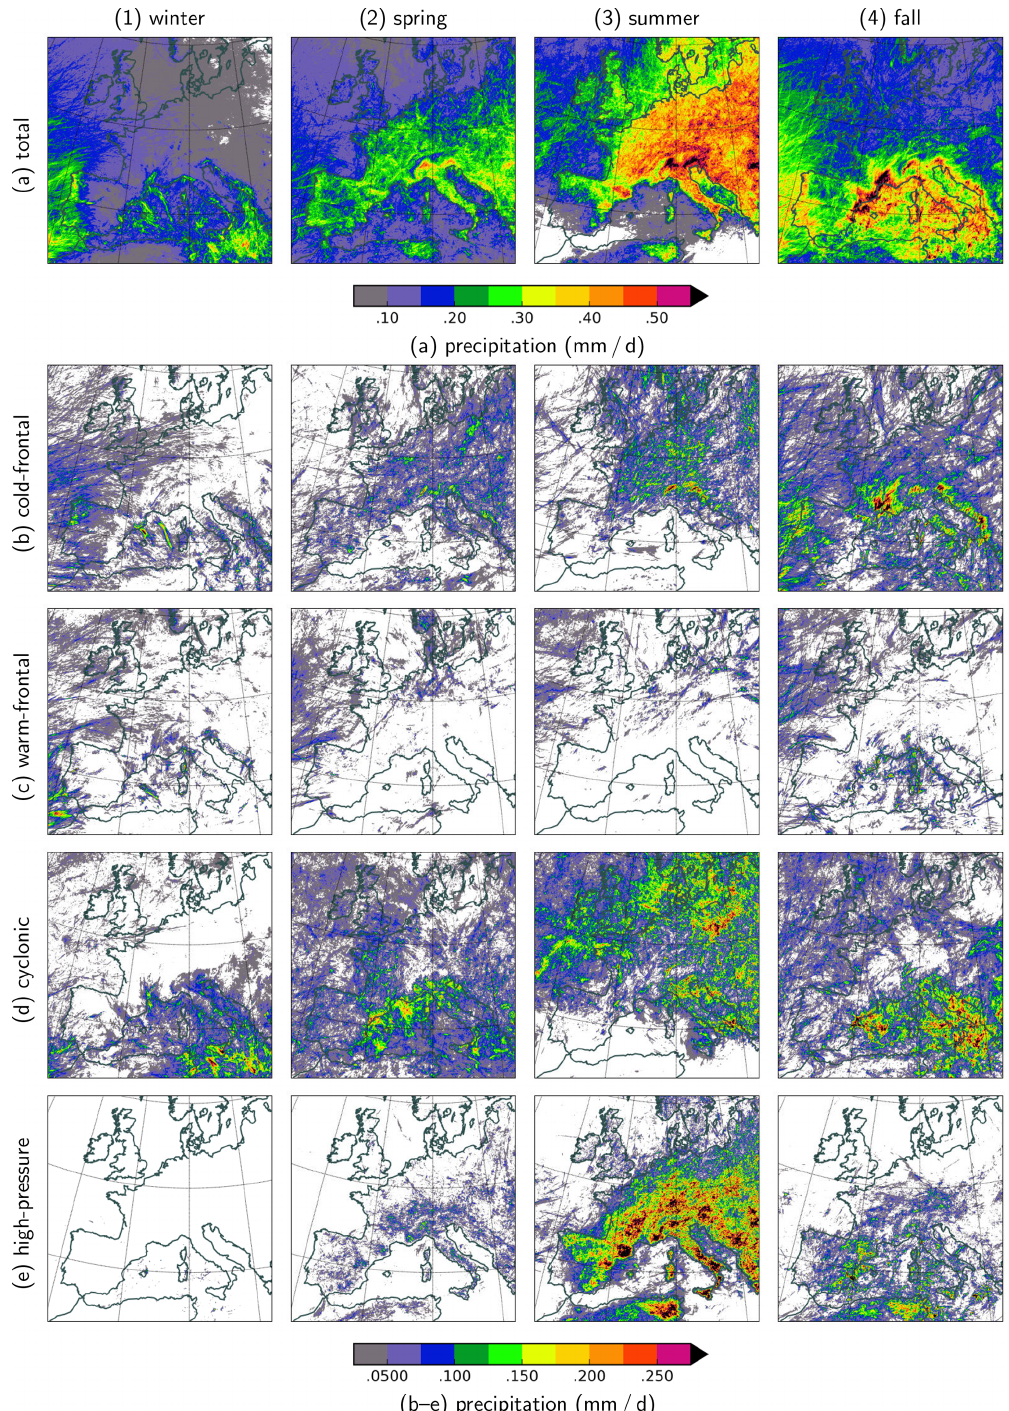
Figure 11. Like Fig. 8 but for seasonal heavy precipitation, defined as the amount exceeding the local 99.9th all-hour percentile of hourly precipitation intensity in a given